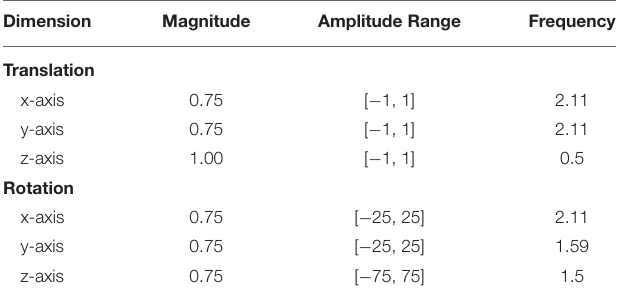
TABLE 1 | Rotational and transitional stimulus parameters determined after